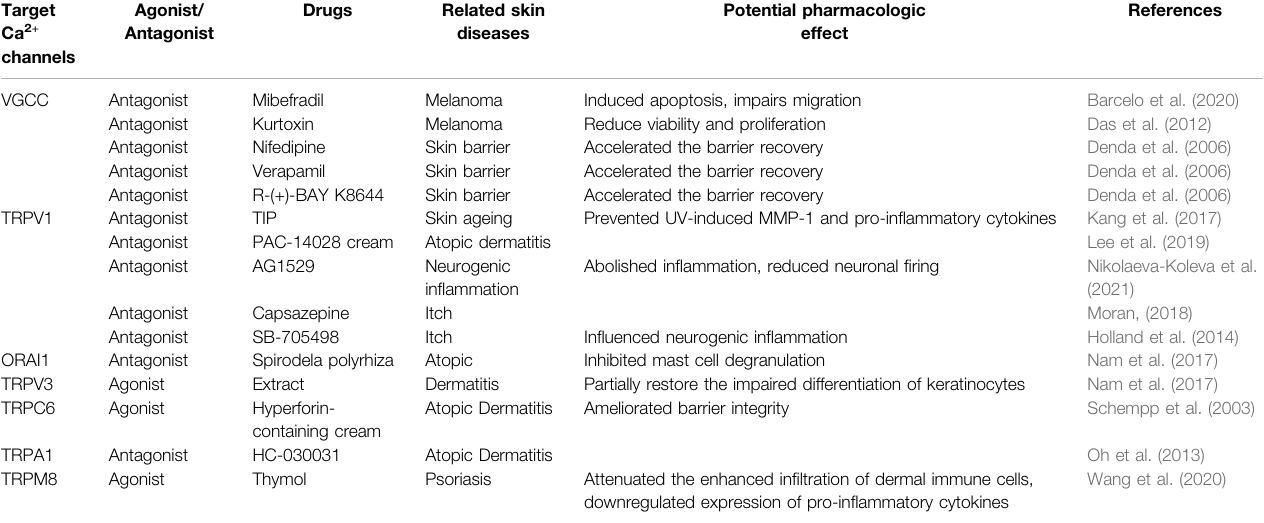
TABLE 2 | Summary of related calcium channels